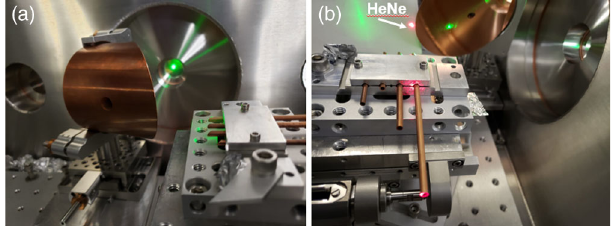
test installed on the translation stage, (2) off-axis parabolic mirror, (3) collimator, (4) spectrometer magnet, (5) diagnostic screen, (6) TPX window, (7) Michelson interferometer, (8) bolo- meter, (9) a dog-leg lattice, (10) energy collimator.